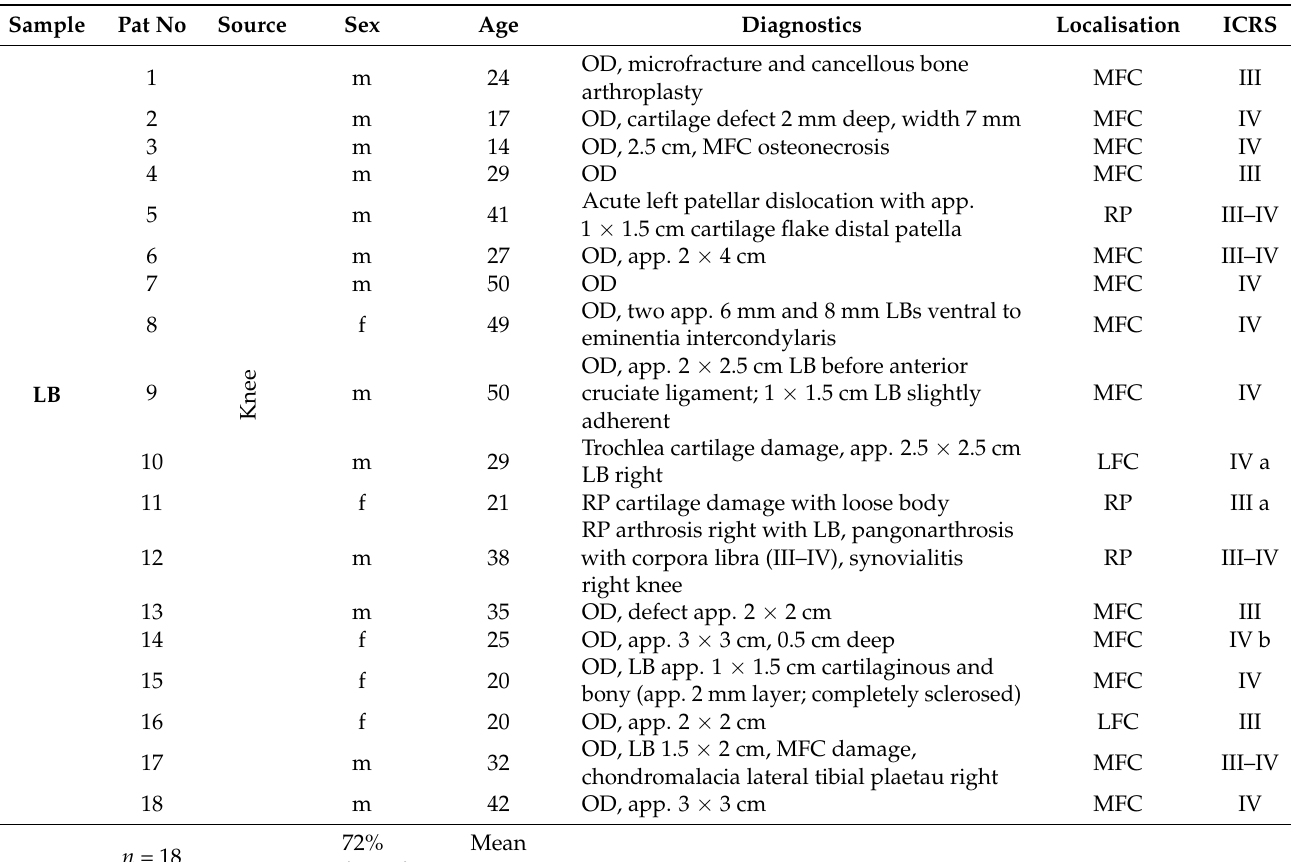
Table 1. Demographic data and diagnostics. Summary of relevant information of the three sample